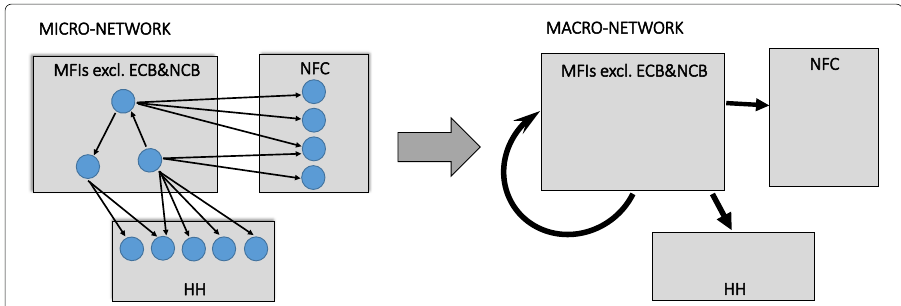
Fig. 1 The euro area macro-network of financial exposures as a result of a two-dimension aggegation: by country and by institutional sector. The euro area macro-network of financial exposures is obtained by aggregating i) the nineteen macro-networks of financial exposures among the institutional sectors operating in the nineteen countries belonging to the Eurozone and their mutual interactions, illustrated as shadows of the macro-nodes (i.e., the grey rectangles) in the left-hand side of the picture, and ii) the micro-based granular financial exposures among the different institutions (i.e., the micro-nodes, represented as blue circles) operating within every institutional sector, as represented in the left-hand side of the picture. This two-dimension aggregation leads to the euro area macro-network of financial exposures, represented in the right-hand side of the